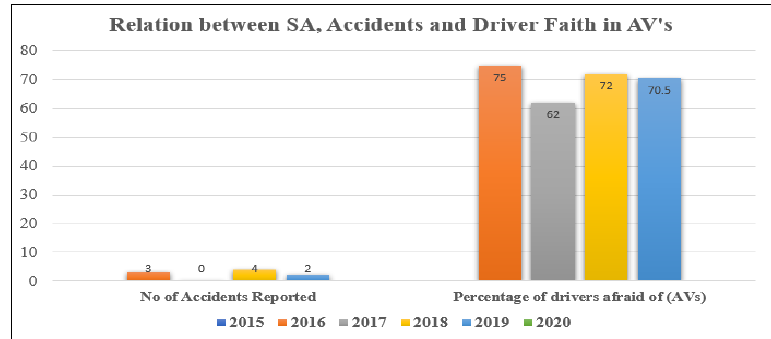
Figure 9. The relation between SA, accidents, and driver faith in AVs